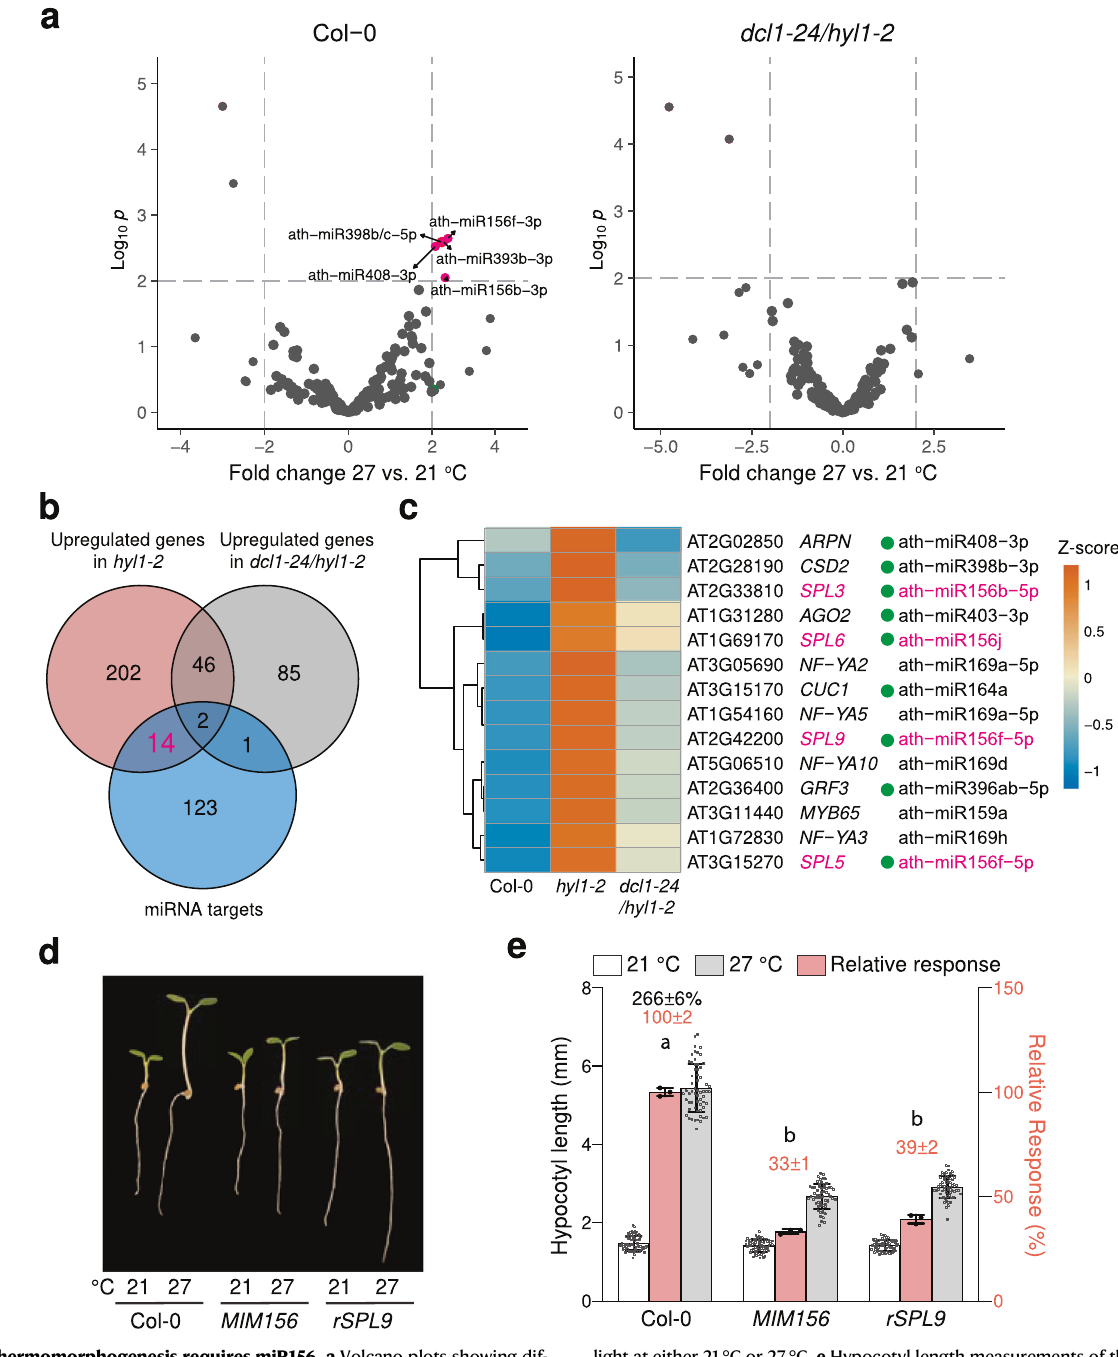
light at either 21°C or 27°C. e Hypocotyl length measurements of the seedlings in ( d )andtheirrelativeresponsestothehighertemperature.Errorbarsrepresents.d. ( n =60 seedlings). The black number above the Col-0 columns represents the percent increase in hypocotyl length (mean ± s.d., n =3 independent biological replicates)at27°Ccomparedwith21°C.Thepinkbarsshowthewarm-temperature responseofamutantrelativetothatofCol-0(setat100%).Pinknumbersshowthe mean ± s.d. of the relative responses. Different lowercase letters above the bars denote statistically signi fi cant differences in the relative responses (ANOVA, Tukey ’ s HSD, p <0.01, n =3 biological replicates). Error bars for the relative responses represent the s.d. of three biological replicates. The centers of the error barsindicatethemean.Thesourcedataunderlyingthehypocotylmeasurementsin ( e ) are provided in the Source Data fi le.